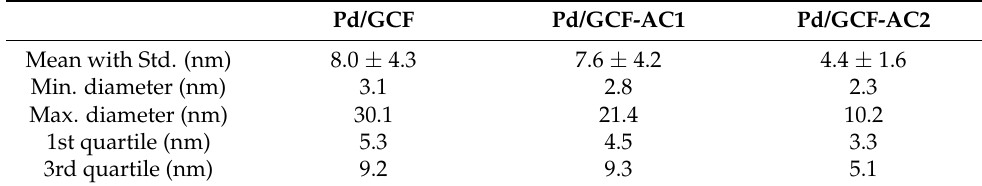
Table 1. Statistics for the particle size of palladium.